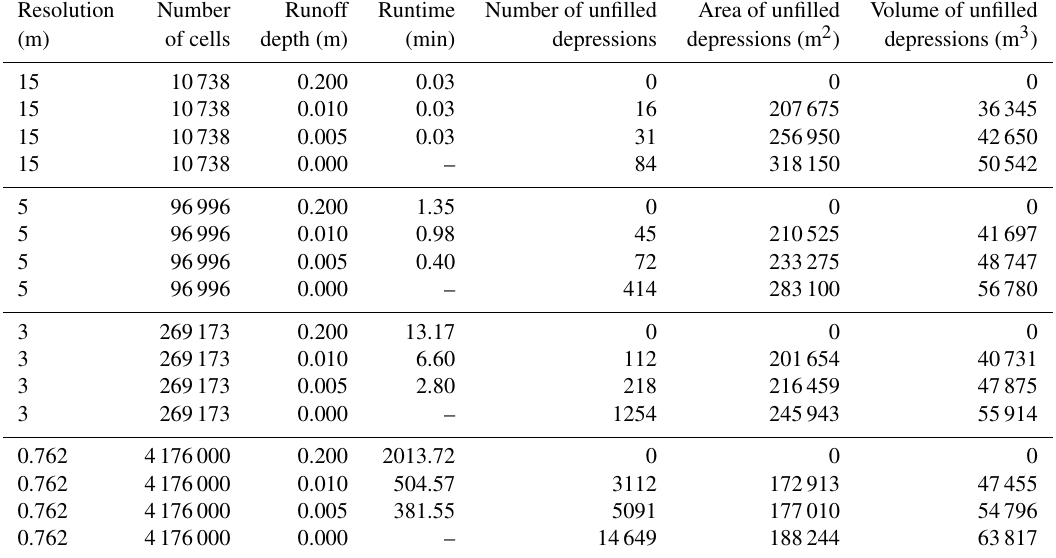
Table 3. FlowFill runs on a subset of the Sangamon study site at four different resolutions and with varying amounts of starting runoff. Runtimes increase with the depth of applied runoff and with an increasing number of cells in the domain. Compute times per cell can be seen in Fig. 11. The number of depressions is greater at higher resolutions: the number of depressions scales linearly with the number of cells in the domain, where number_of_depressions = (0 . 0034756 × number_of_cells ) + C . Depression areas tend to be greater at coarser